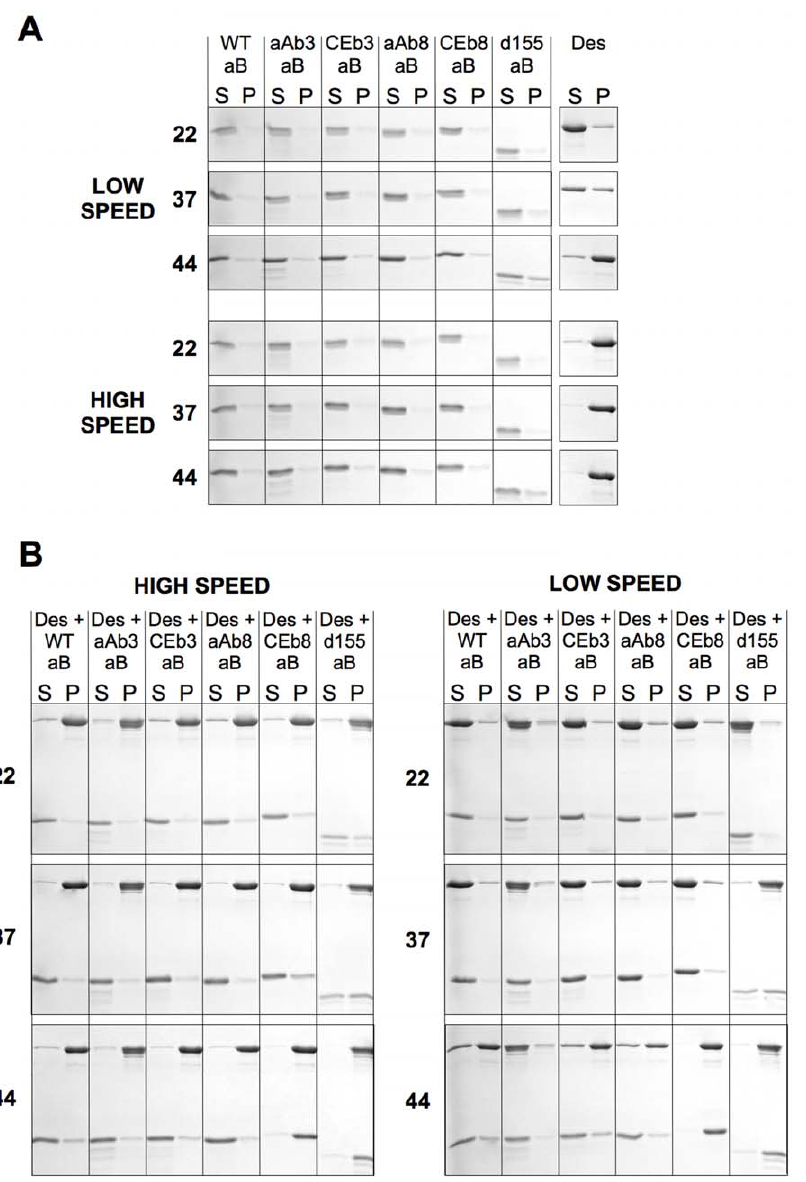
Figure 5. Gel electrophoretic analysis of the low- and high-speed sedimentation properties of desmin and wild type and mutant a B- crystallins. (A) The low- and high-speed sedimentation properties of each individual protein was determined at 3 different temperatures. The pellet (P) and supernatant (S) fractions were analysed by SDS-PAGE and the proportion of each protein in each fraction determined. By high-speed sedimentation assay, which measures the efficiency of desmin assembly, virtually all the desmin had pelleted at 22 u , 37 u and 44 u C. By low-speed sedimentation assay, there was a temperature dependent increase in the proportion of desmin sedimented. The a B-crystallin remained largely in the supernatant fractions of both sedimentation assays. (B) Analysis of desmin pelleted by high- and low-speed sedimentation assay in the presence of either wild-type or the various a B-crystallin protein constructs at three different temperatures. a A b 3 a B-crystallin (aAb3 aB) reduced the proportion of desmin filaments sedimenting at low-speed at 44 u C. Conversely, the CE b 8 and the D 155–165 a B-crystallin protein constructs induced the complete low-speed sedimentation of desmin at 44 u C. For each sedimentation assay, the band intensities were quantified and then combined with two other data sets to determine statistical significance and summarized in Figs. 5 and